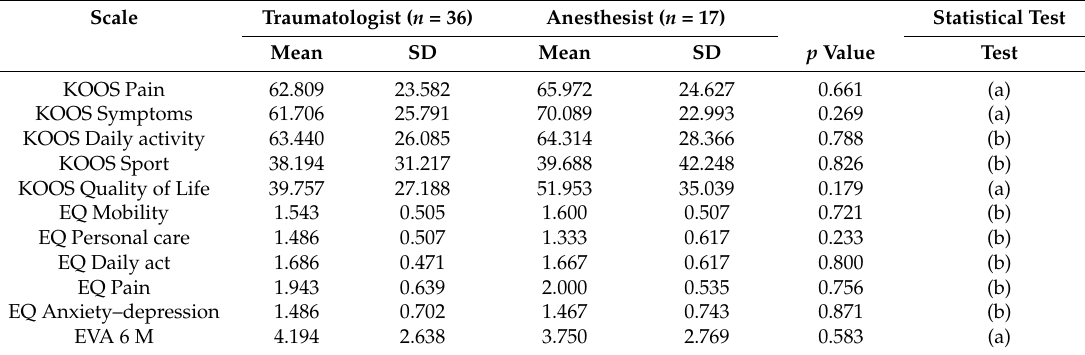
Table 8. Six months postinfiltration VAS, EQ and KOOS scores according the treating